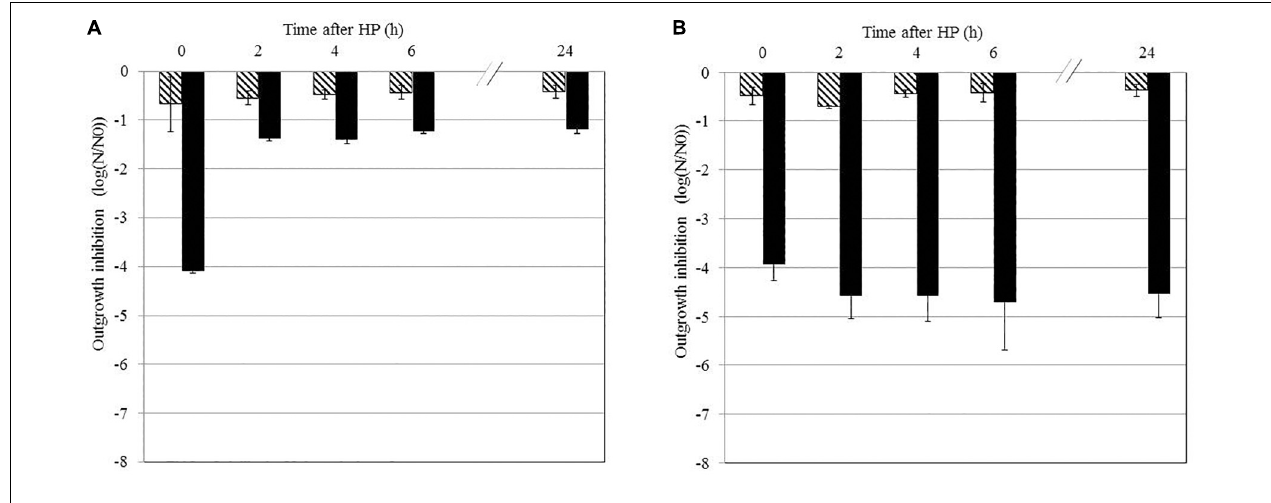
FIGURE 2 | Effect of the storage time after high-pressure (HP) treatment on the sensitivity of Bacillus subtilis PS533 spores to nisin. Reduction of HP-treated spores after storage at 4 ◦ C for 0, 2, 4, 6, or 24 h measured by plating on Luria broth (LB) medium (striped bars) or LB medium supplemented with 50 IU/ml of nisin (black bars). (A) HP processed at 20 ◦ C; (B) HP processed at 50 ◦ C. Error bars represent SD calculated from